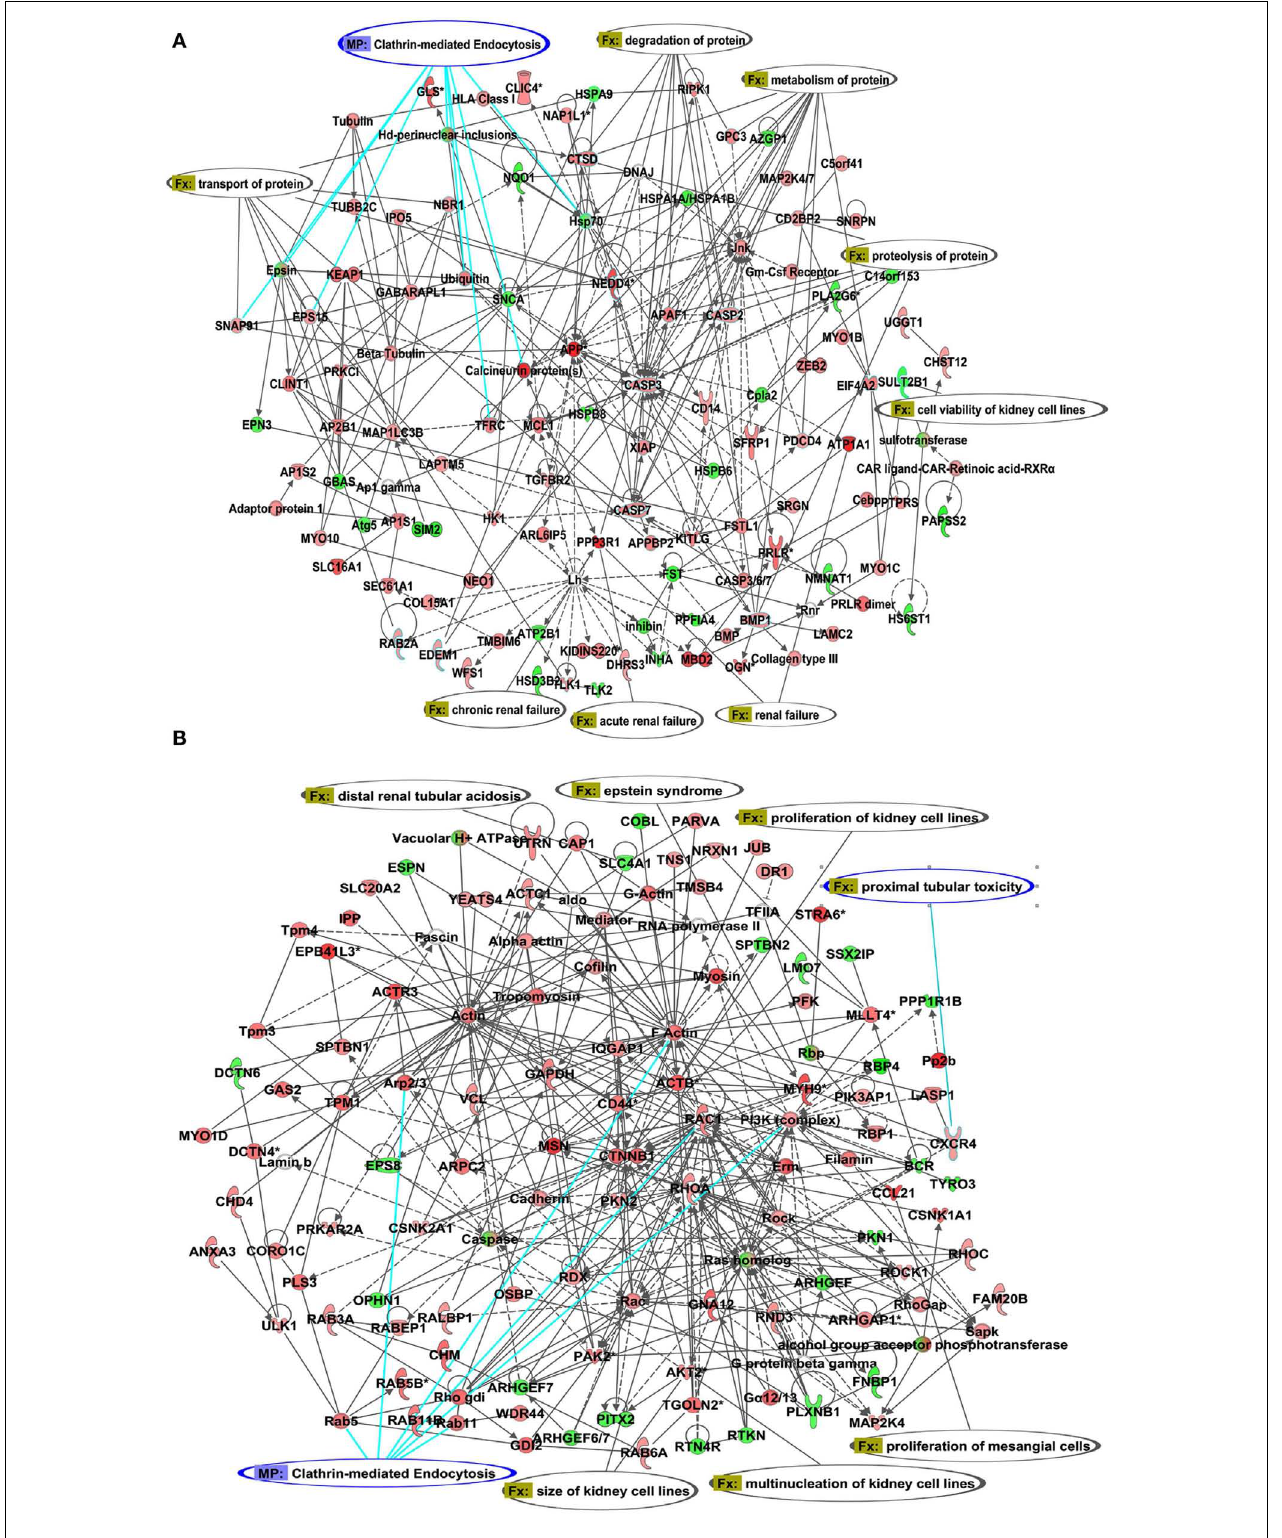
transcripts shown in green were down-regulated in the congenic strain compared with S.The fold changes of the corresponding Affymetrix probes are given in TableA1 in